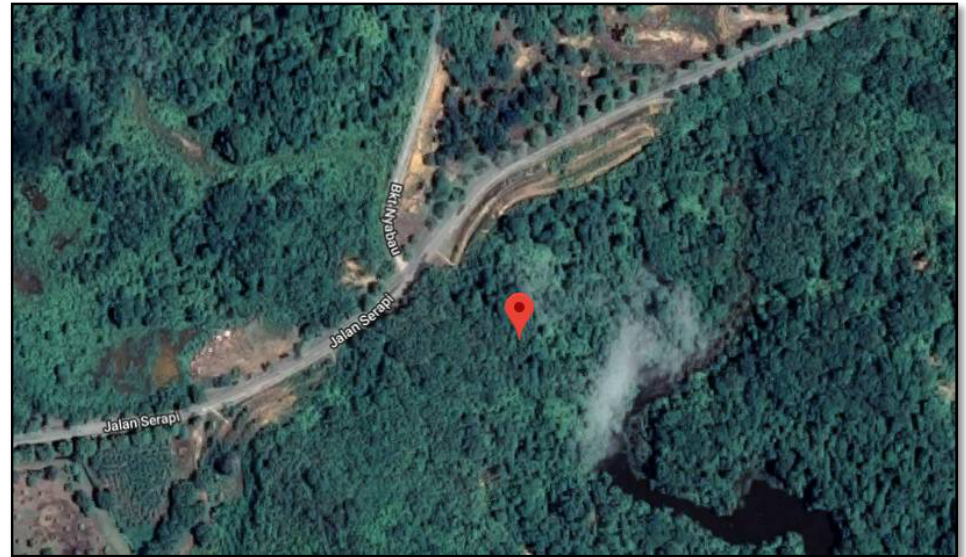
Figure 1. Aerial view of the location where the soil was sampled for laboratory analyses (3°12′19.4″ N, 113°04′22.8″ E).